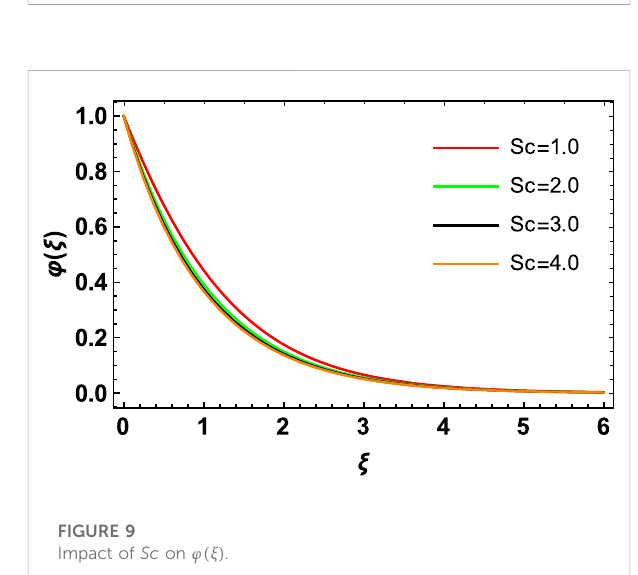
FIGURE 8 Impact of γ on φ ( ξ ) .